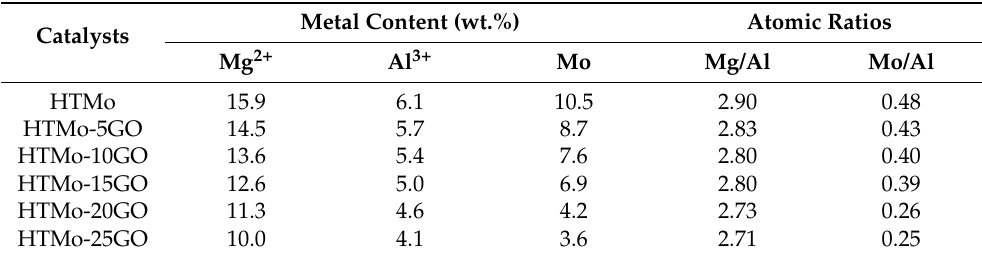
Table 1. Metal content in the samples as determined by ICP-AES analysis.